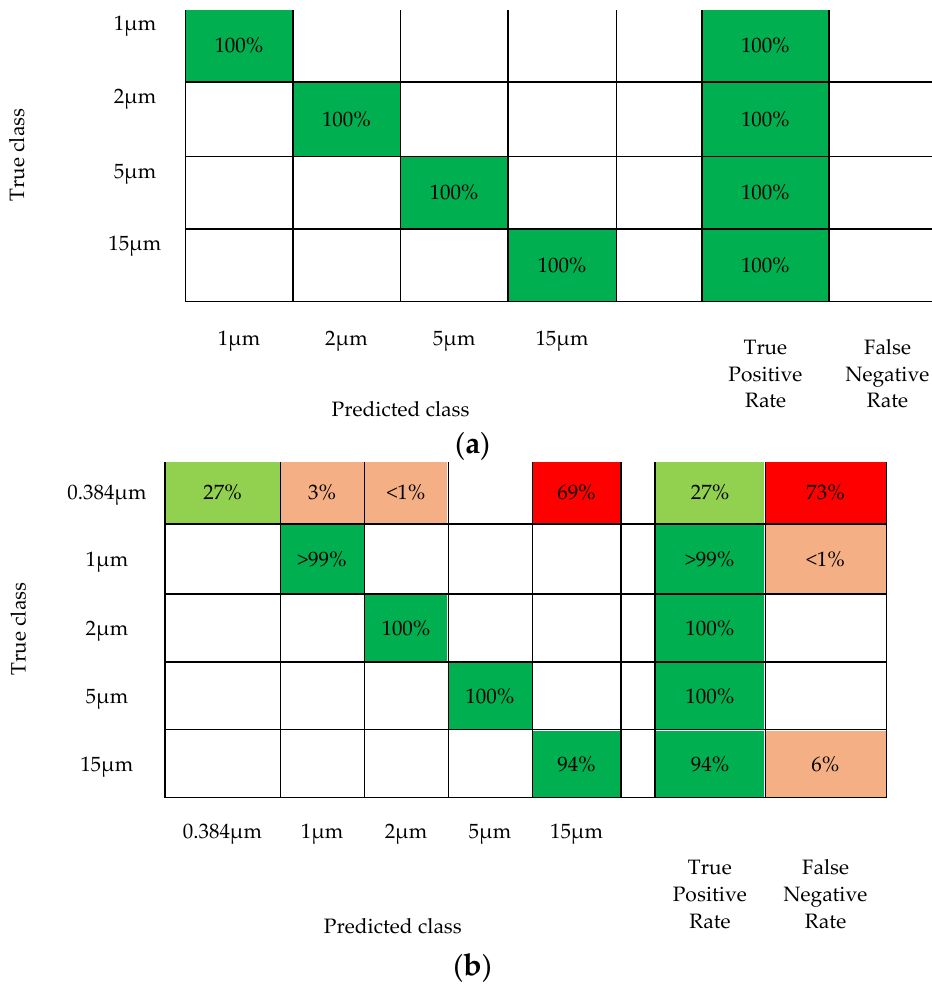
Figure 6. Confusion matrix of different sizes of scatterers: ( a )—without 384 nm PBs; ( b )—with 384 nm PBs. The SVM-based classification of various scatterers’ concentrations with PCA reached 86.7% of accuracy and 99.9% without PCA (Table 2). Along with other GLCM properties, contrast and angular second moment (ASM) discriminated the most benefit to the classification performance during the feature selection process, the example of which is illustrated in Figure 7a: clusters of various phantom types were separable in the feature space, except 20 µ L and 30 µ L of scatterers in 2% gelatin solution. Figure 7b shows the similarity of textures generated by these two phantoms: 60% of 30 µ L PBs was classified as a 20 µ L PBs sample. With a refractive index (RI) of PBs equal to 1.57, SiO 2 has the lower RI—1.43 [29]. Classification with and without PCA in both scenarios correctly discriminated the texture of differing scatterers in all cases. The principal component scores of each scattering particle for the 3 components are plotted in X, Y and Z dimensions (Figure 8a). According to the type of scatterers (PBs = red, SiO 2 = blue), the segregation of the clusters into different types along the components can be detected. To illustrate the distribution of the groups along with individual components, plots (b), (c) and (d) are